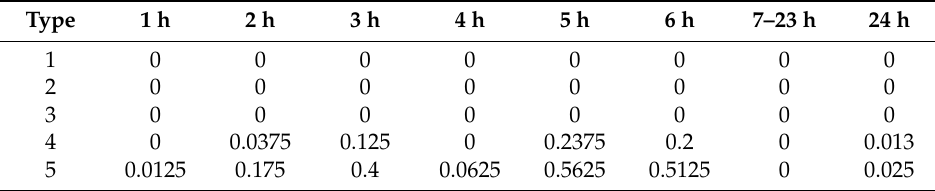
Table 5. The LLOAF states of different types of coal-fired units in the L1-SUC.